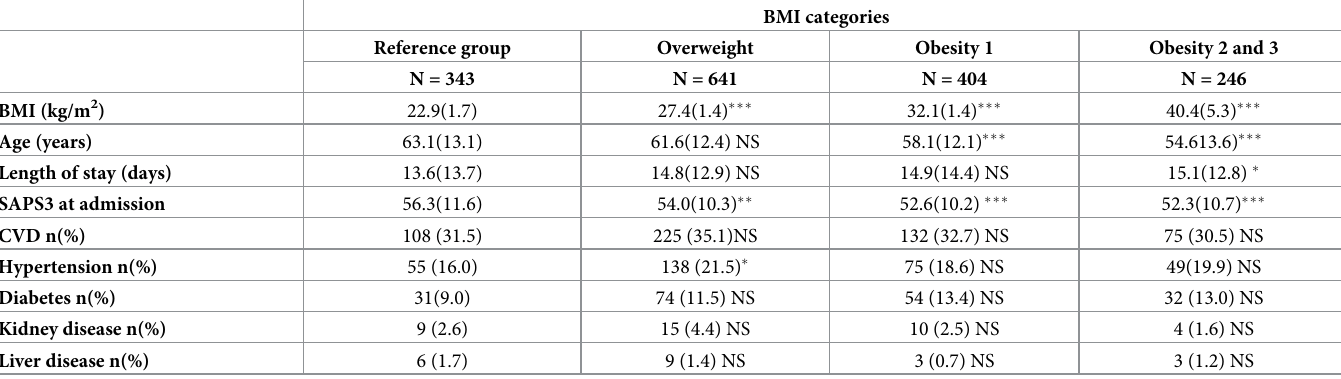
Table 2. Cohort characteristics across BMI